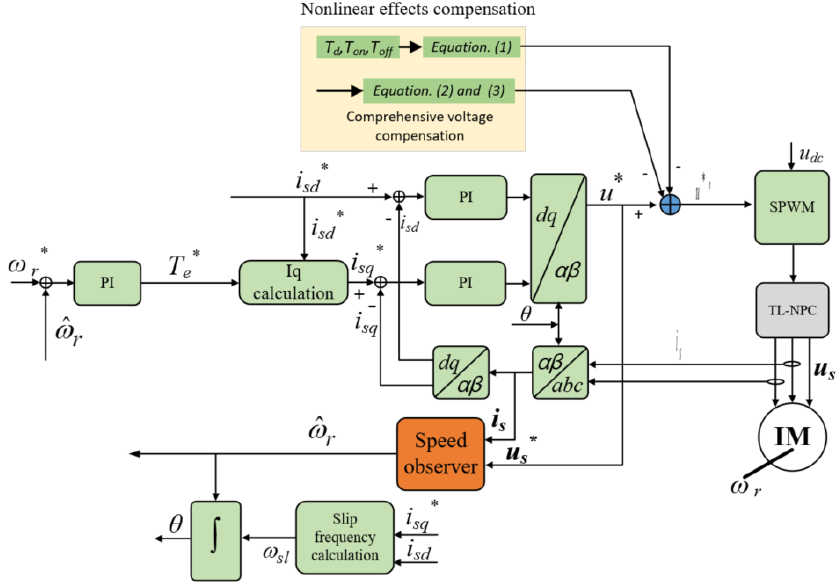
Figure 11. The control flowchart showing the whole procedure of the controller with the proposed method.